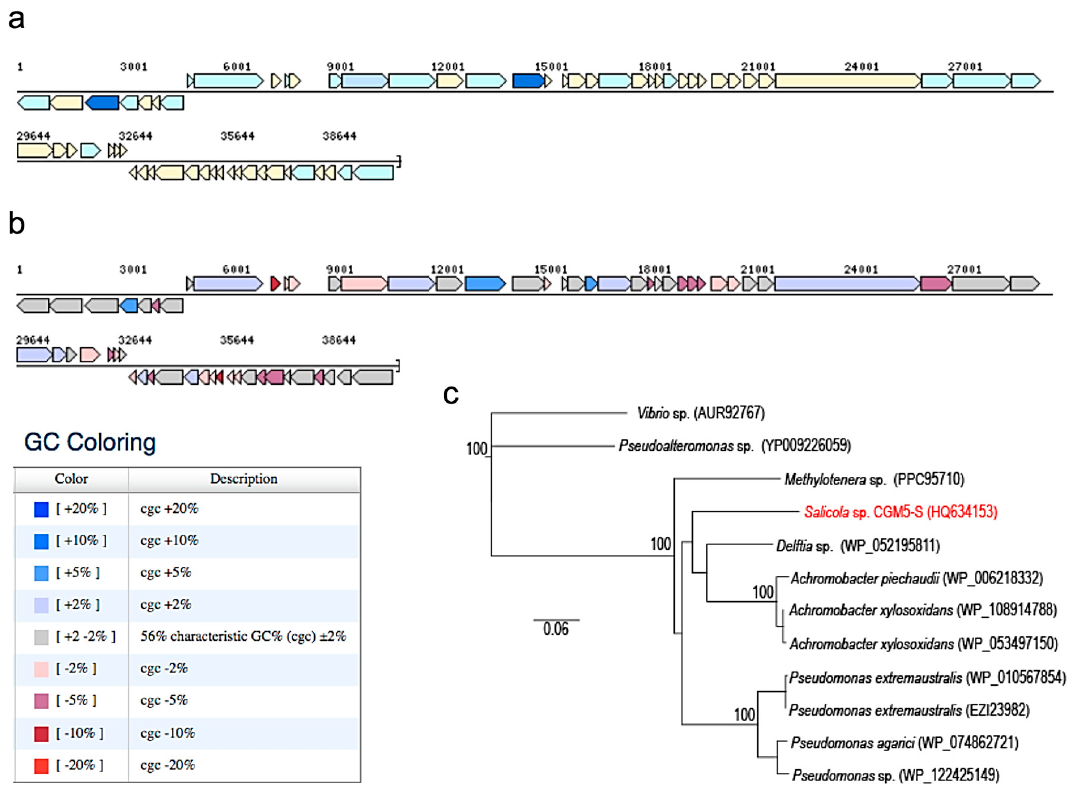
Figure 3. Genomic structure of CG φ 29 generated using the chromosome viewer function in JGI-IMG. ( A ) Coding sequences color-coded using pFAM gene category annotations. Dark blue are ‘replication, recombination and repair’, light blue are ‘unclassified function’, and beige are ‘hypothetical proteins’. ( B ) GC content mapping with legend showing deviations from mean GC (56%). ( C ) Neighbor-joining dendrogram depicting relationship of the CG φ 29 terminase gene sequence (red) with closely related sequences (species names of bacterial phage hosts are depicted on branches with accession numbers). Numbers at nodes represent bootstrap confidence values for neighbor-joining tree expressed as percentages from 1000 pseudoreplicates each. The Vibrio sp. and Pseudoalteromonas phage sequences were used as outgroups.